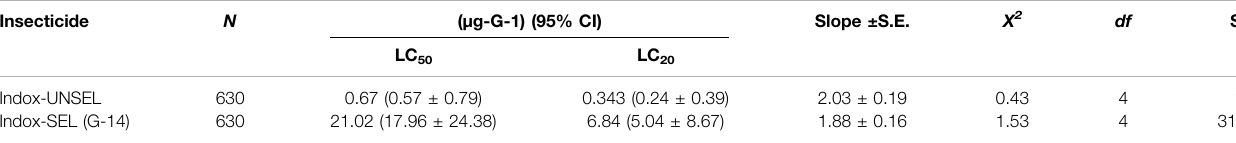
The95%CIofRRwerecalculatedaccordingtoRobertsonandPreisler(1992)andconsideredsigni fi cantifthesedidnotincludethevalueof1. N :Numberofindividualsexposedwas630 insects and constant acrossall bioassays; degreesoffreedom (df) was 4. CI = Con fi dence interval.RR = Resistanceratio a RR = LC 50 value ofinsecticides of Indox-SEL-G14divided by LC 50 value of insecticides of